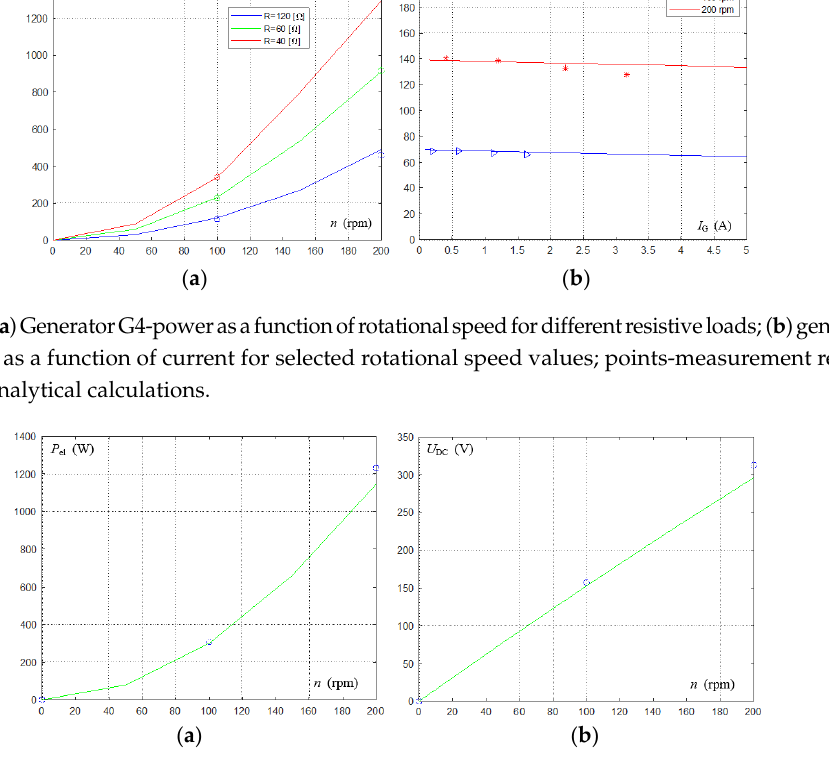
Figure 32. Generator G4: ( a ) voltage changes with the rectifier load; ( b ) electric power changes with rectifier load; for selected rotational values, points-measurement results, solid line-analytical calculations.